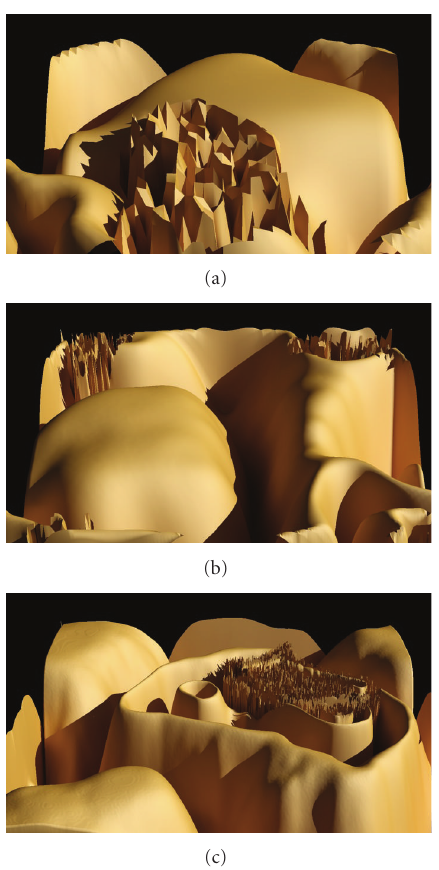
Figure 13: Exotic terrains generated by TP in (5), with resolutions 50 × 50, 150 × 150, and 450 ×